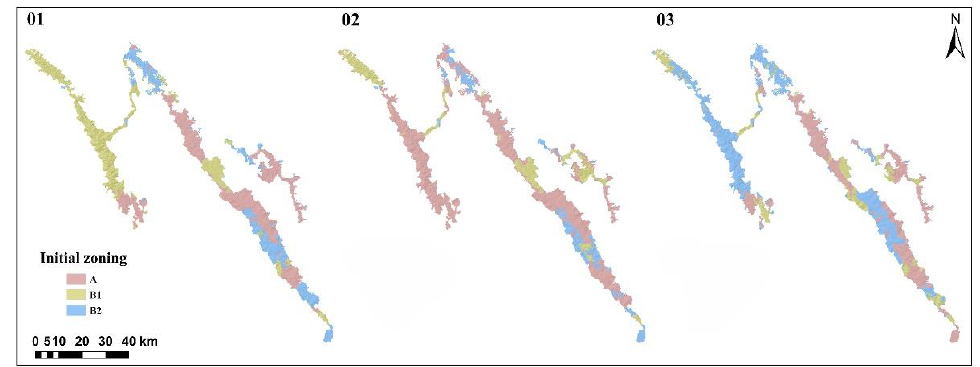
Figure 7. Comparison of preliminary zoning schemes (01, average; 02, average among best 50% cells; 03, average among best 30% cells).